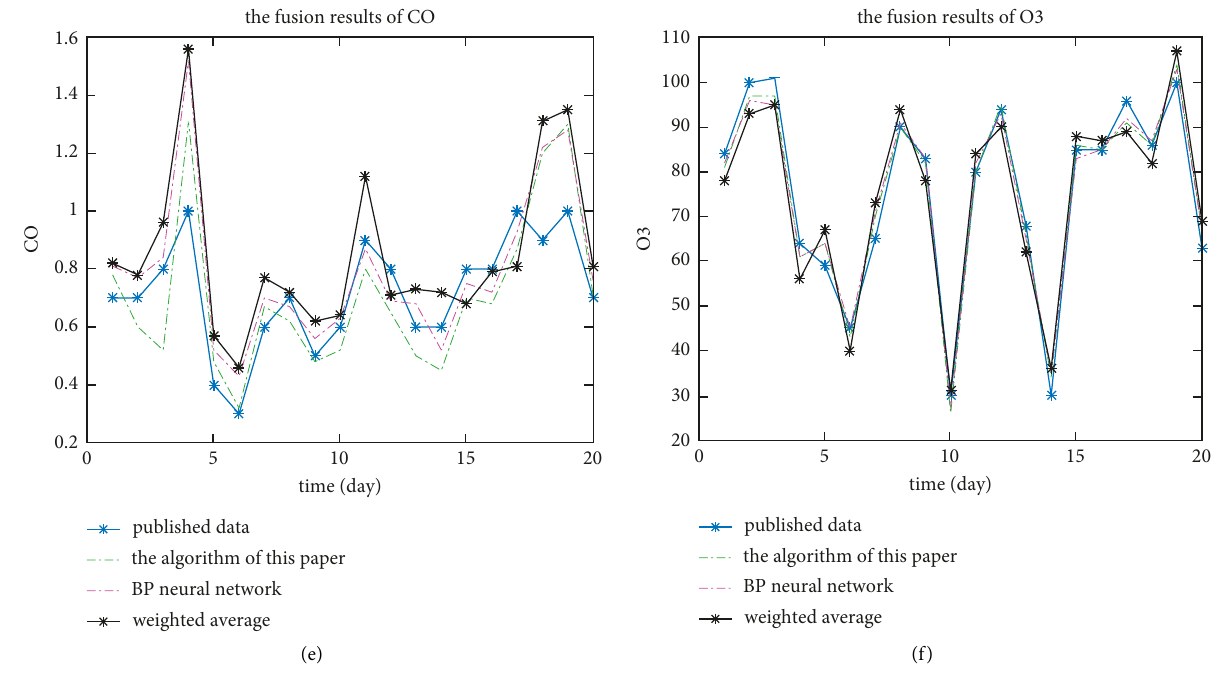
Figure 4: Fusion effect of three algorithms on air quality